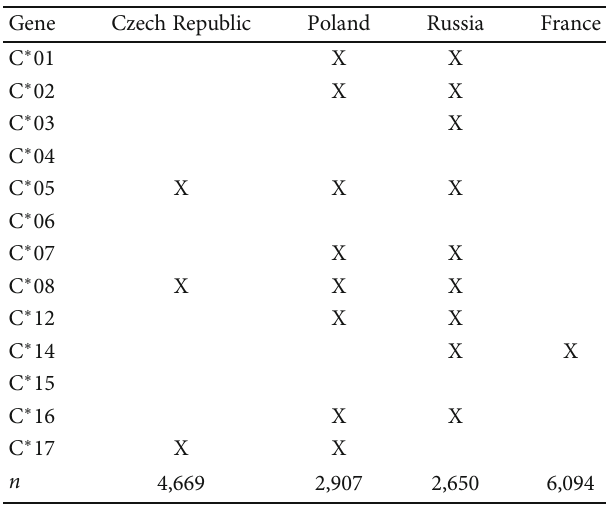
Table 6: Comparison of HLA-C gene frequencies in the Transylvanian ( n = 1,847 ) vs. other European population groups.